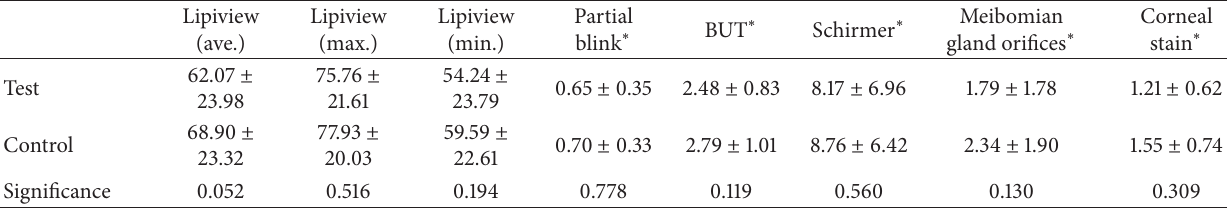
Table 1: Baseline parameters.